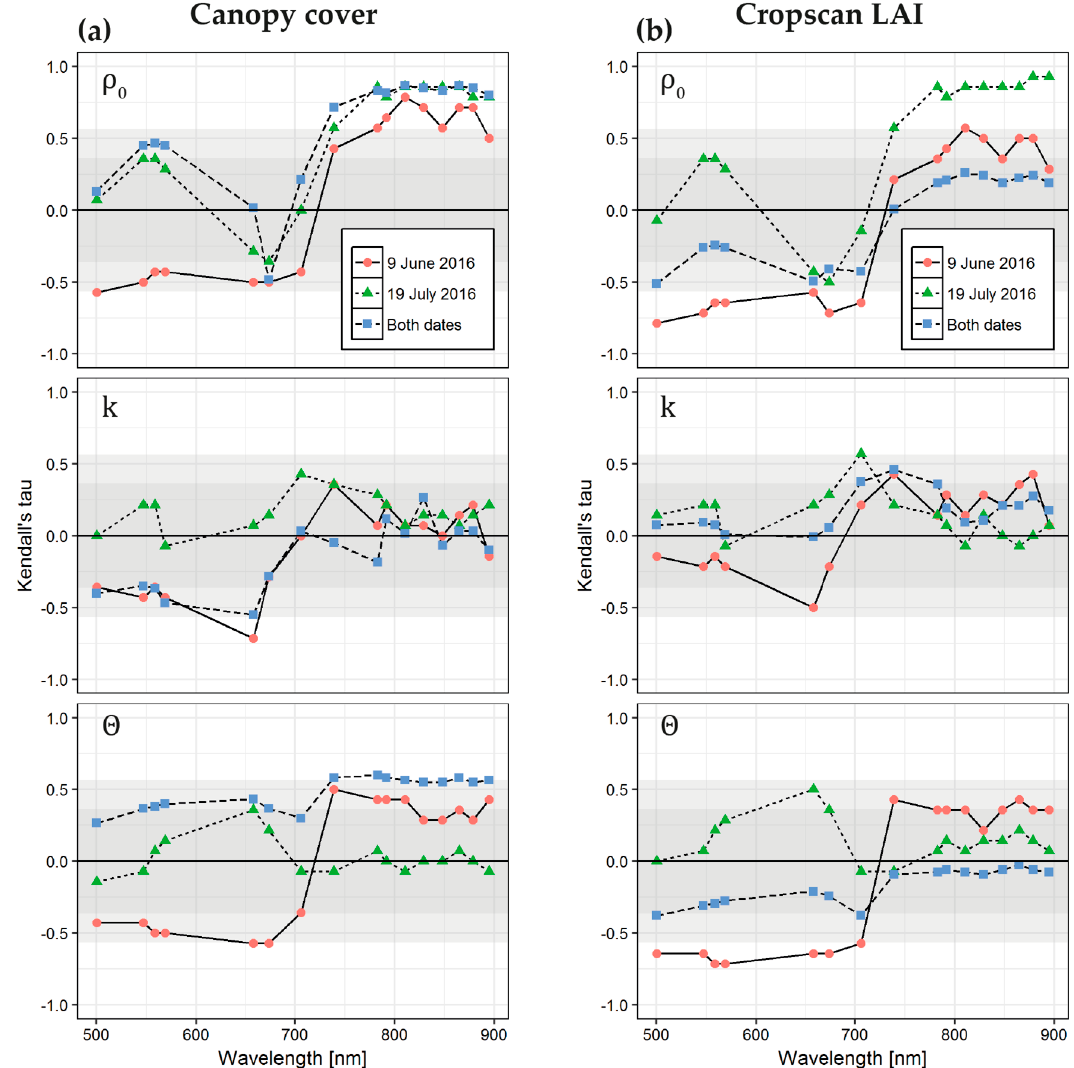
Figure 11. Ranking correlation (Kendall’s tau) between the ρ 0 , k , and Θ parameters of the RPV model and the canopy cover ( a ) and Cropscan LAI ( b ) for the flights of Day 1 and Day 2 separately and for the flights of both days combined. The gray-shaded areas indicate the significance levels: values above or below the dark-gray areas were significant for the analysis of both dates (n = 16) and values above or below the light-gray areas were significant for the analysis of the separate days (n = 8), both at the 5% confidence level.